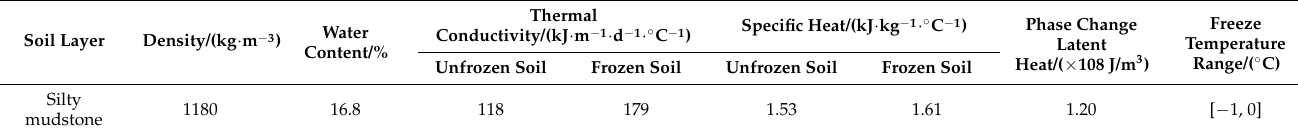
Table 5. Freezing time plan for brine temperature.